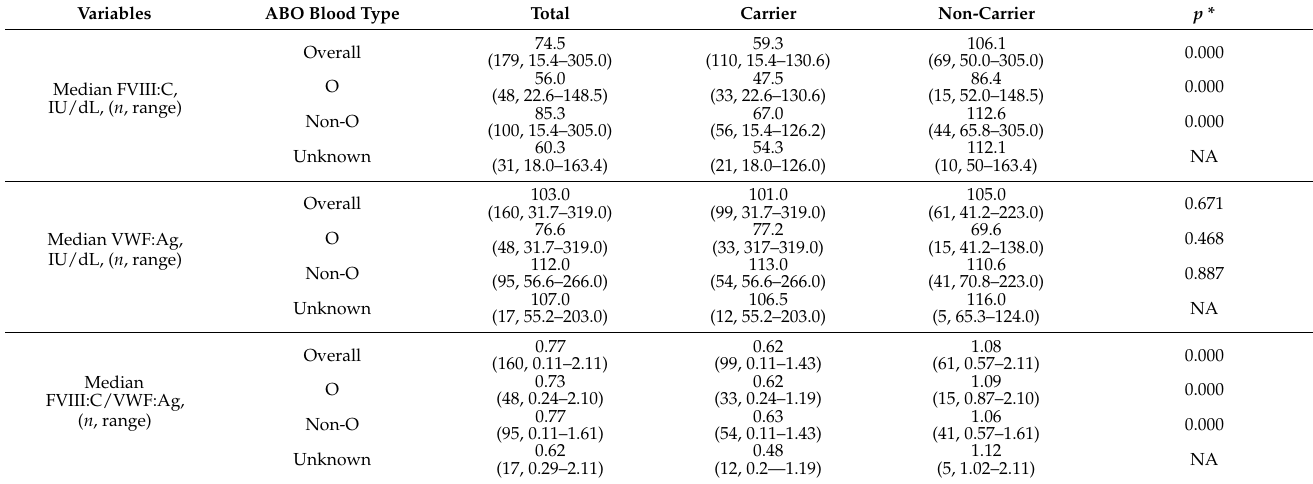
Table 2. FVIII:C, VWF:Ag, and FVIII:C/VWF:Ag ratio by carriership and ABO blood